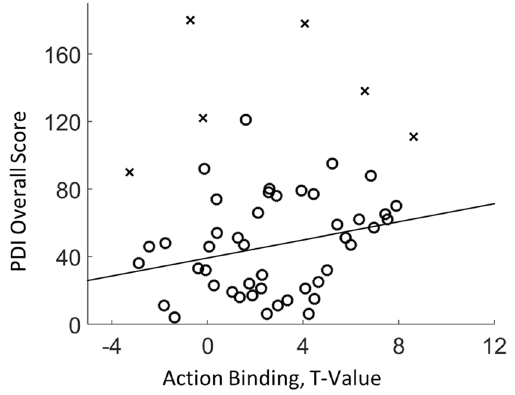
Figure 3. Scatter plot between PDI overall score and action binding. A high PDI overall score is associated with a strong action binding effect. Each circle represents a participant. Outliers are marked by crosses. The solid line shows the linear fitting between the two